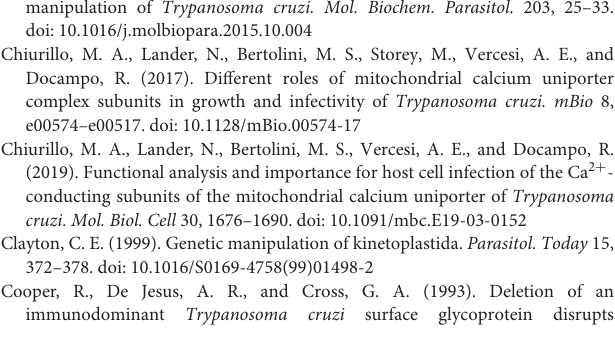
Figure S1 | Effect of different glucosamine concentrations on growth of epimastigotes in SDM-79 medium. Values are means ± s.d. of n = 3. Table S1 | Primers used in this